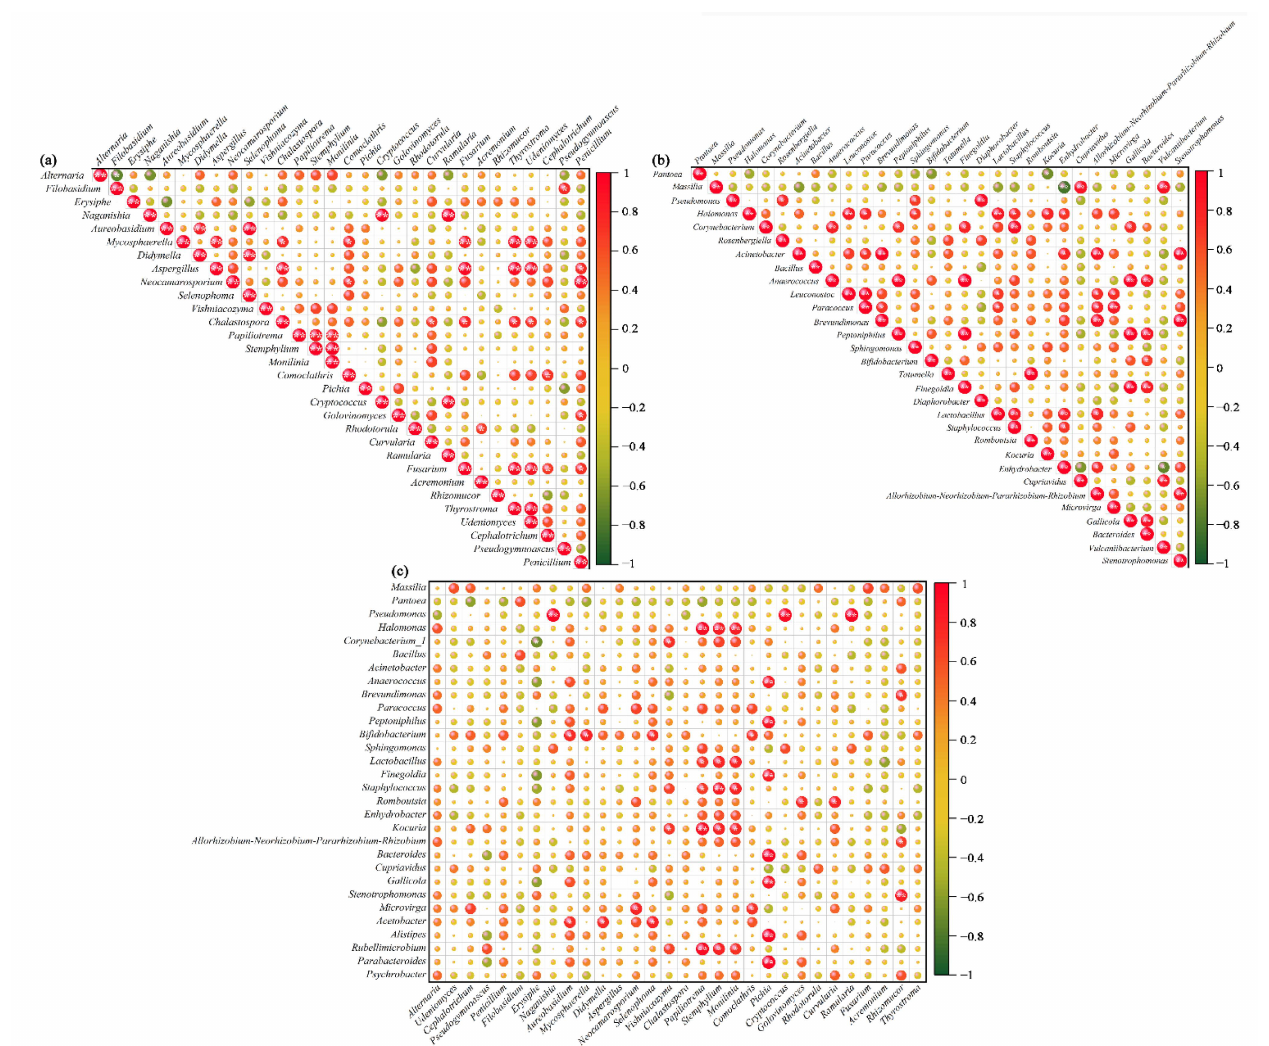
Figure 8. Co-occurrence and co-exclusion relationships between different bacteria ( a ) and fungi ( b ) and between bacteria and fungi ( c ). The Pearson rank correlation matrix showing the abundances of the top 30 fungi and bacterial genera is depicted. Strong and weak correlations are indicated by the large and small circles, respectively. The color of the scale bar denotes the nature of the correlation; 1 indicates a perfect positive correlation ( red ) and − 1 indicates a perfect negative correlation ( green